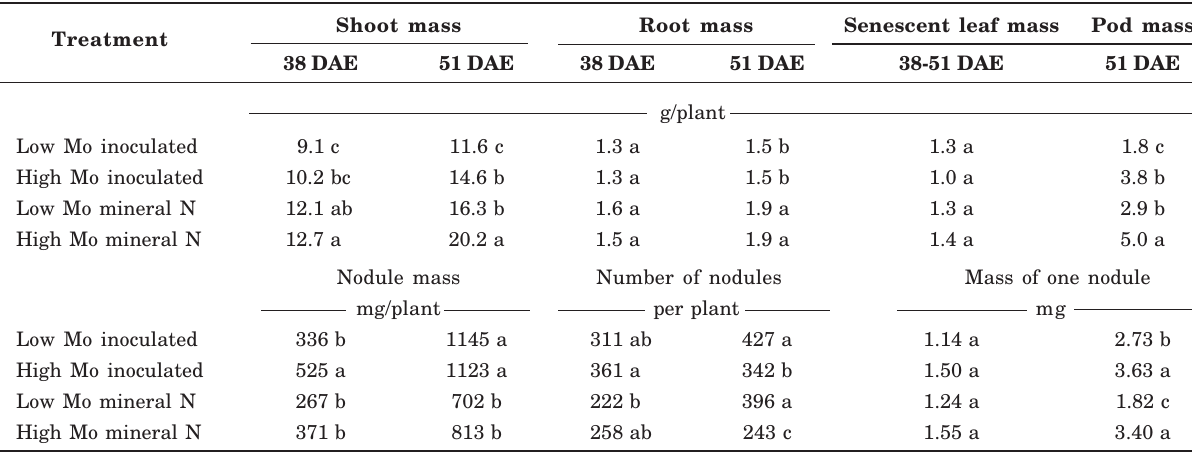
Table 3. Mass of shoots, roots, senescent leaves, pods and nodules, number of nodules, and mass of one nodule, of common bean plants originating from seeds with low or high Mo concentration grown at two N sources (inoculated with rhizobia or mineral N), at two growth stages (in days after emergence - DAE), in experiment 2